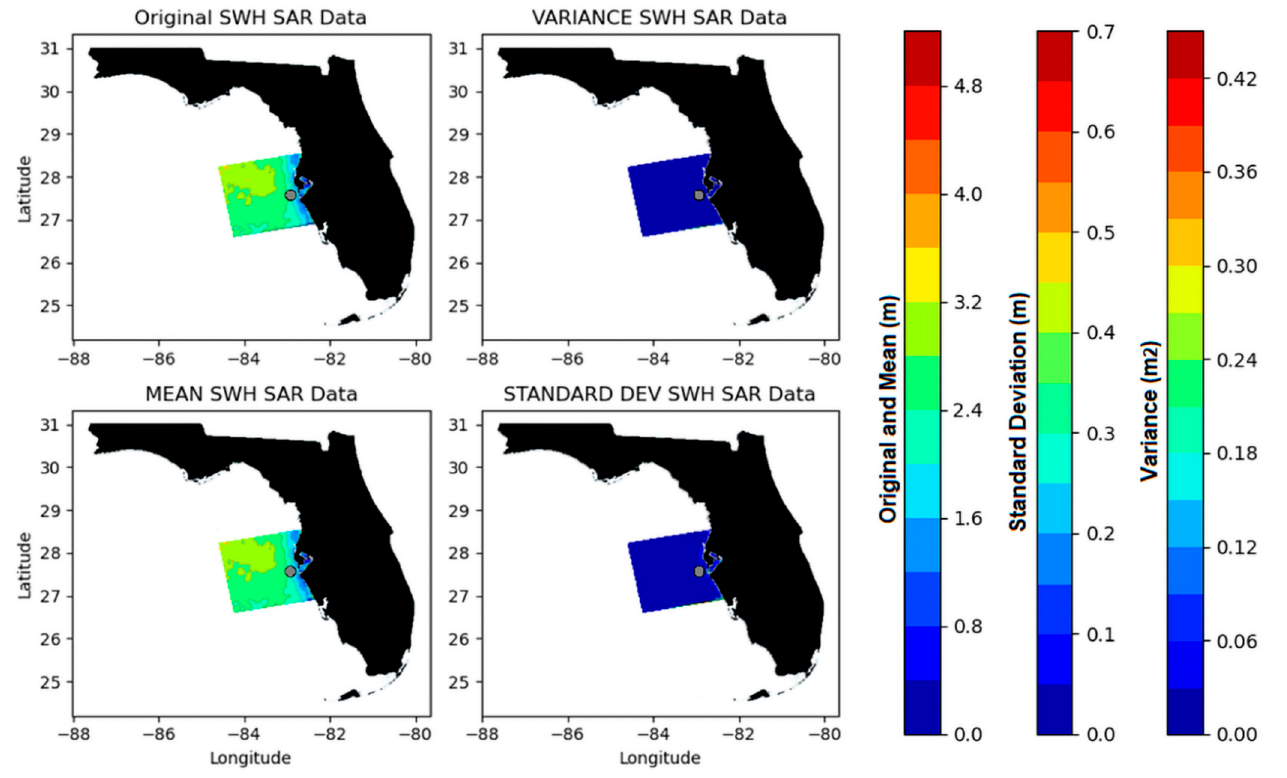
Figure 12. The H s data derived from SAR satellite Sentinel-1 (S1) with Interferometric Wide (IW) swath mode for the date 10 October 2018, which was when several rogue waves were identified by the studied CDIP buoy data. The buoy location is marked in gray. The elevation is measured by the color bar in meters. No color is seen in the variance or standard deviation maps, which indicates that the H s values that were measured were very similar to neighboring values, thereby providing no indication of rogue events in the image.